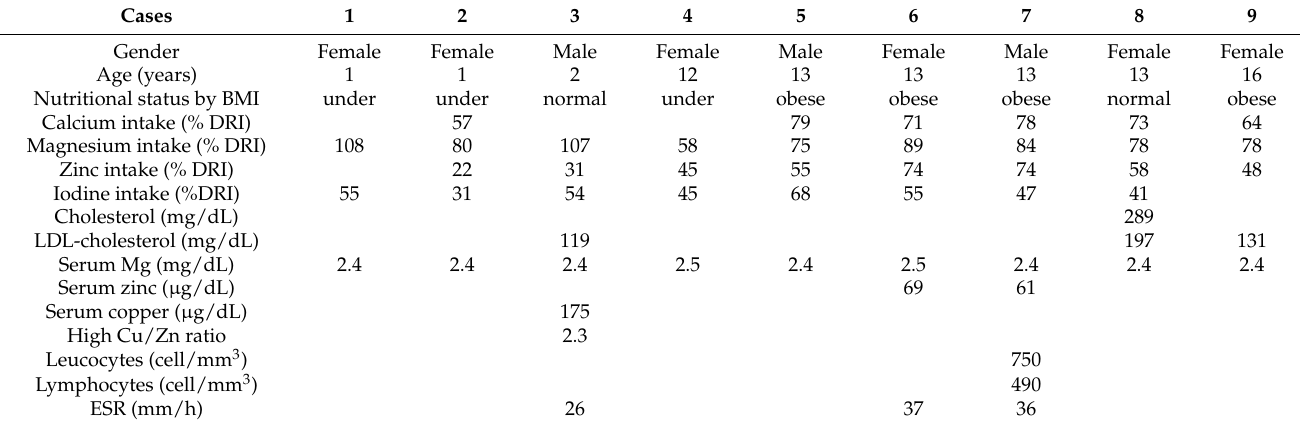
Table 4. Basic characteristic of patients with hypermagnesemia ( n = 9).